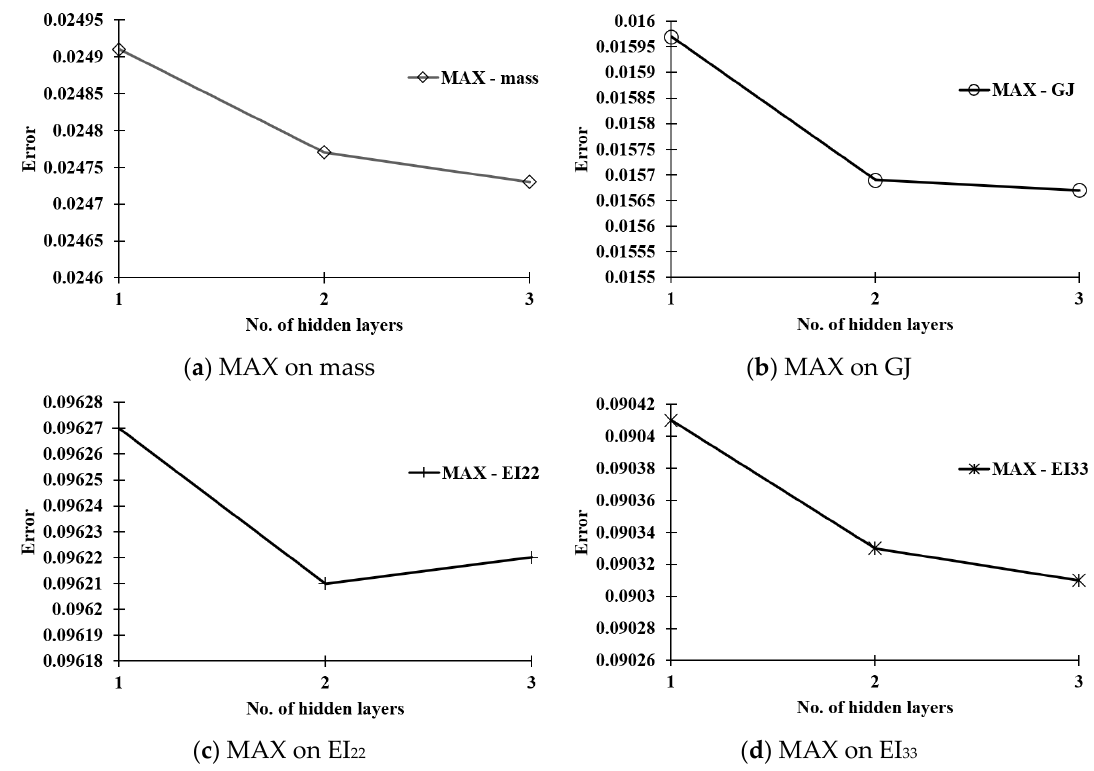
Figure 19. Maximum error according to variation of hidden layer.